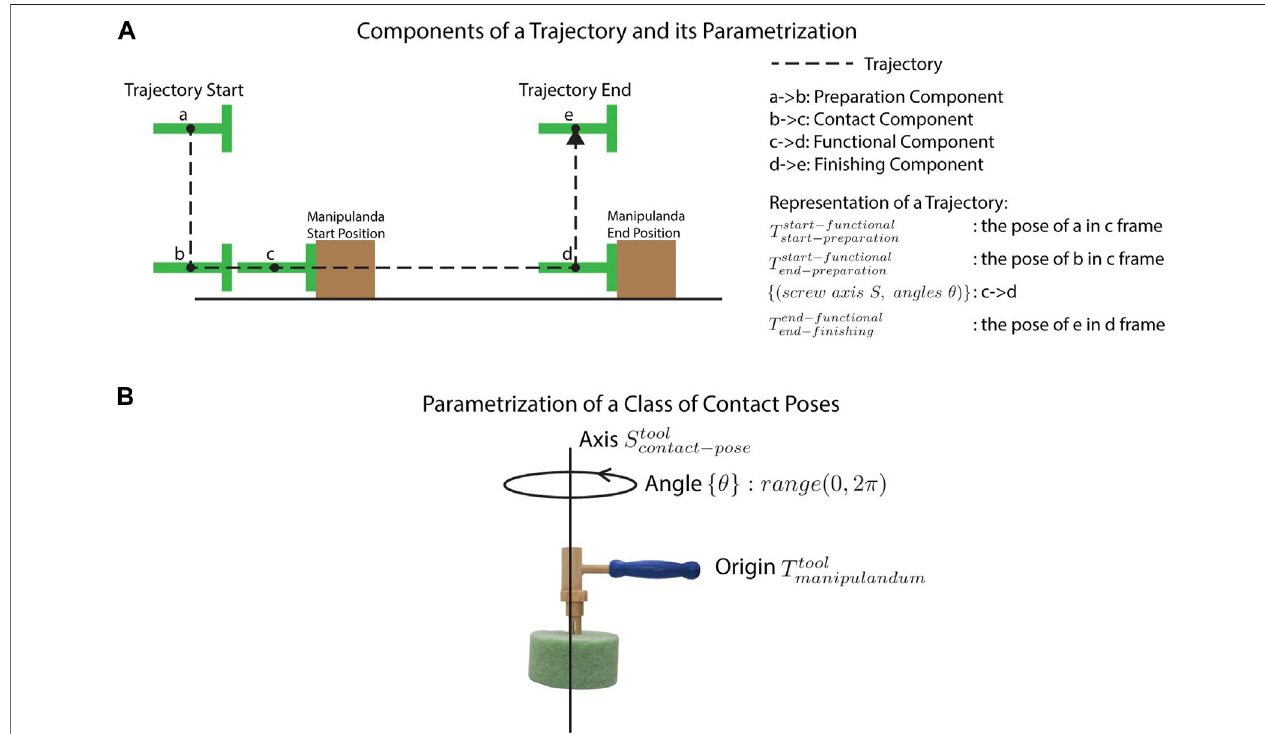
FIGURE 2 | Star 1 illustrations. (A) depicts the four component trajectories that comprise a hypothetical demonstration of a pushing task. (B) depicts the parametrization of a contact pose using a nail-hammering task as an example.